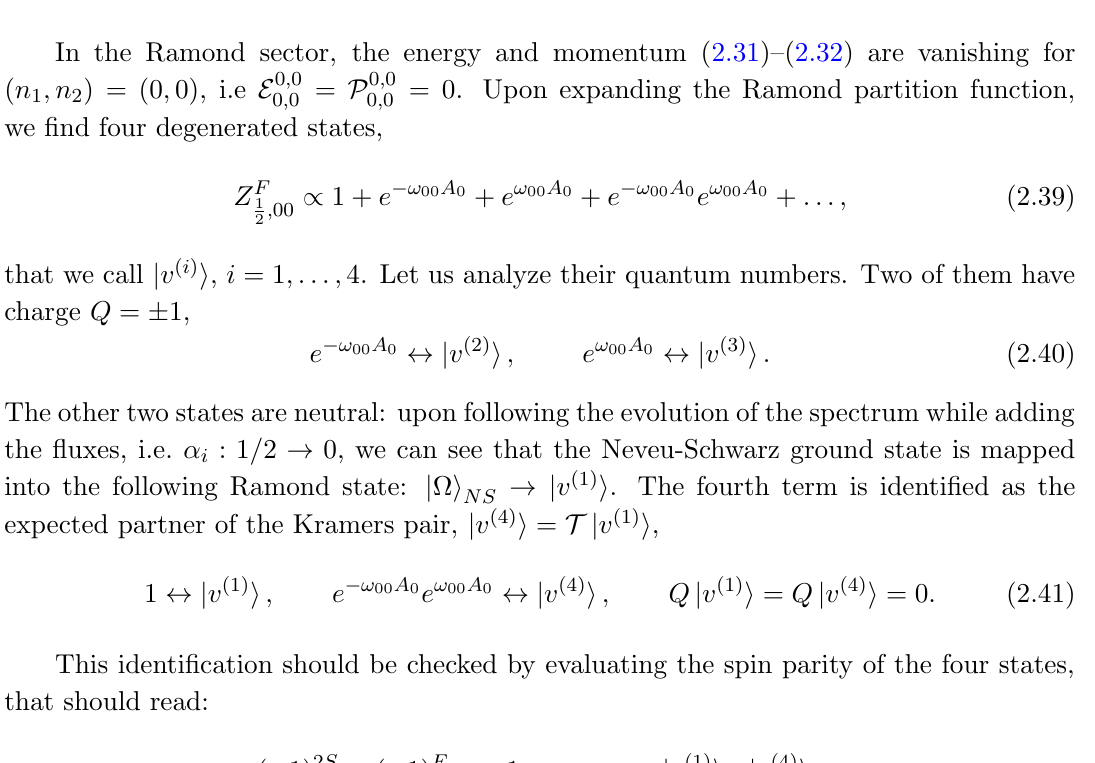
Figure 5 . Transformations of partition functions Z F V 1 = 2 ; the indices (cid:11) (cid:22) = 0 (resp. 1 = 2) indicate periodic (resp. antiperiodic) boundary 2